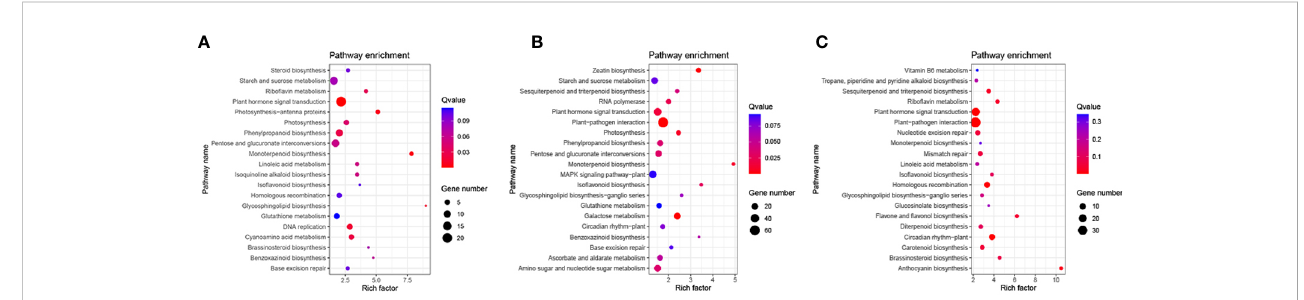
FIGURE 4 KEGG pathway functional enrichment analysis of DEGs. (A) The CK-vs-N5 comparison; (B) The CK-vs-N10 comparison. (C) The CK-vs-N15 comparison. The KEGG pathway name were presented in Y-axis, and the rich factor were presented in X-axis. The color bar and bubble size represent the corresponding q-value and number of genes respectively.